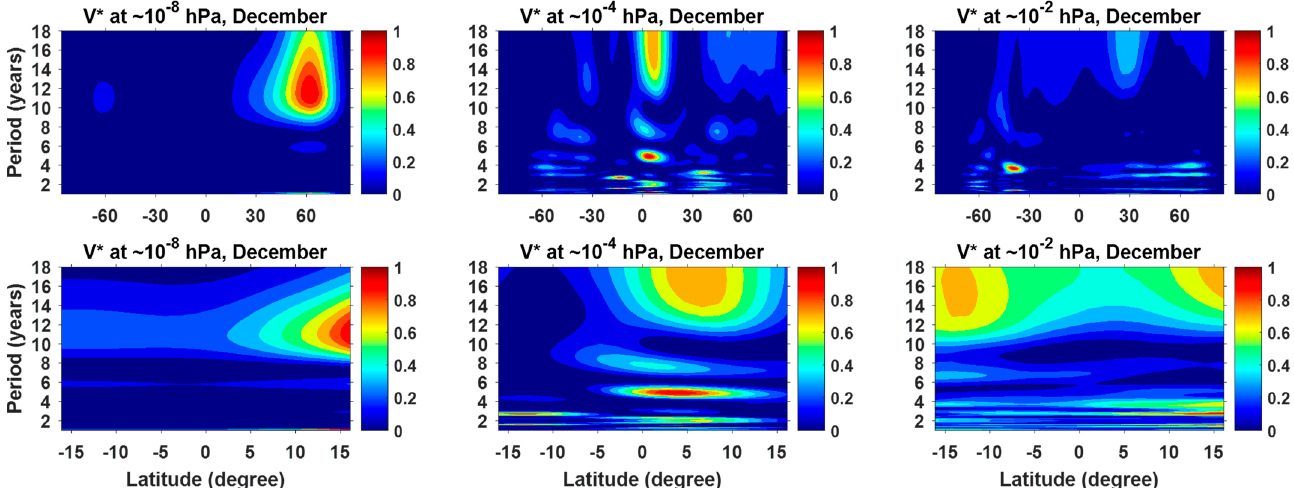
Figure 11. Spectra for the meridional components of atmospheric circulation at ~10 − 8 hPa (left column), ~10 − 4 hPa (middle column) and ~10 − 2 hPa (right column) in June (first two rows) and December (last two rows).